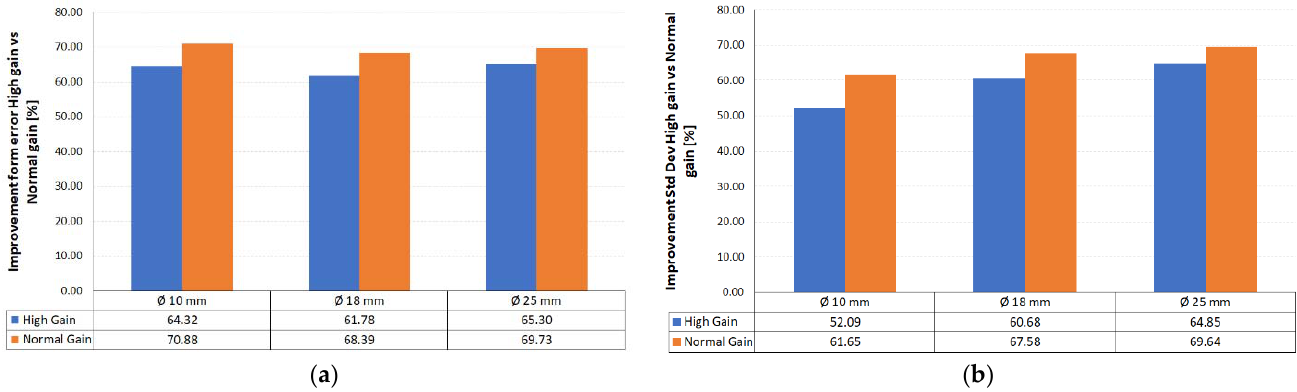
Figure 8. Improvements with medium- and high-gain laser measurements: ( a ) in form deviation; ( b ) in standard deviation.